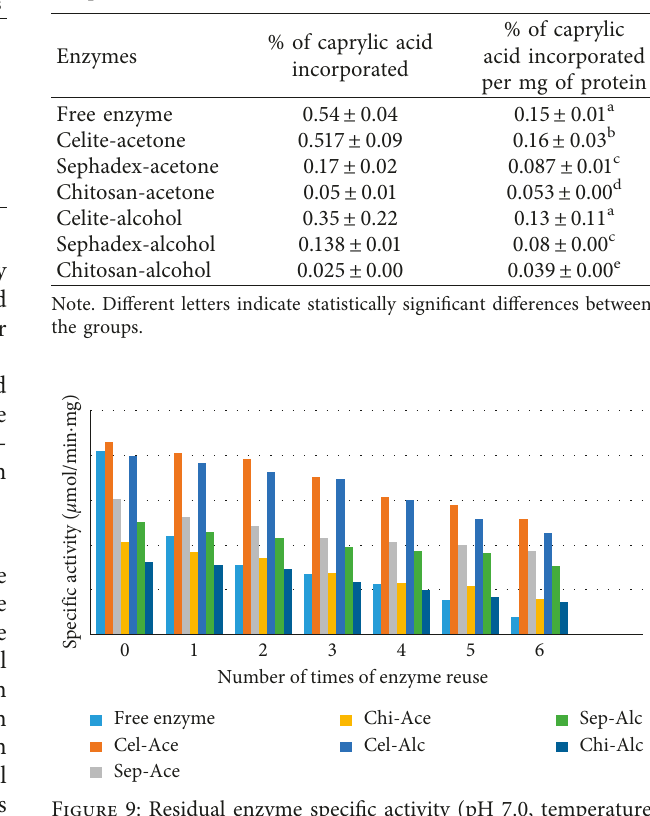
Table 3: Percentage ester conversions. Table 4: Percentage of caprylic acid incorporated into olive oil samples.